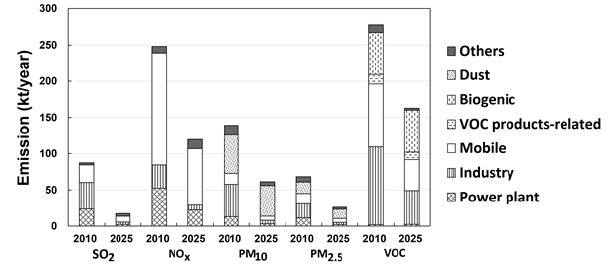
Fig. 7. Total emission amount from each category in Guangzhou in 2010 and 2025.